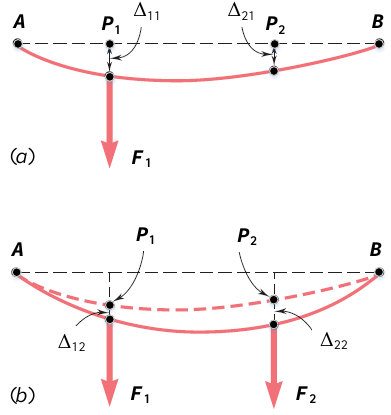
Figure 13. Illustration of meshing forces and the resulting deflections.